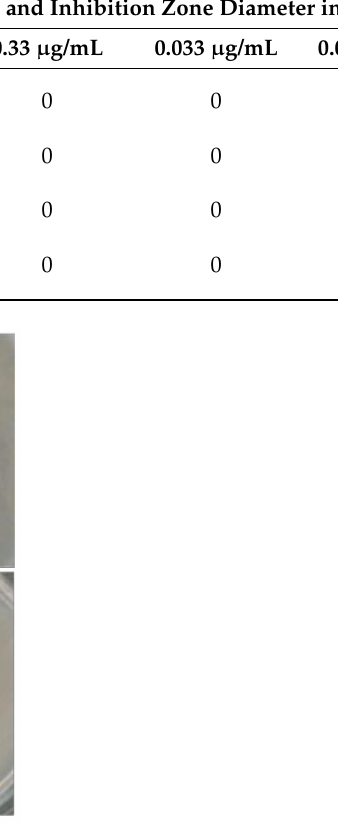
Table 2. Inhibition of different bacterial species exposed to different concentrations of GarKS bacteriocin.